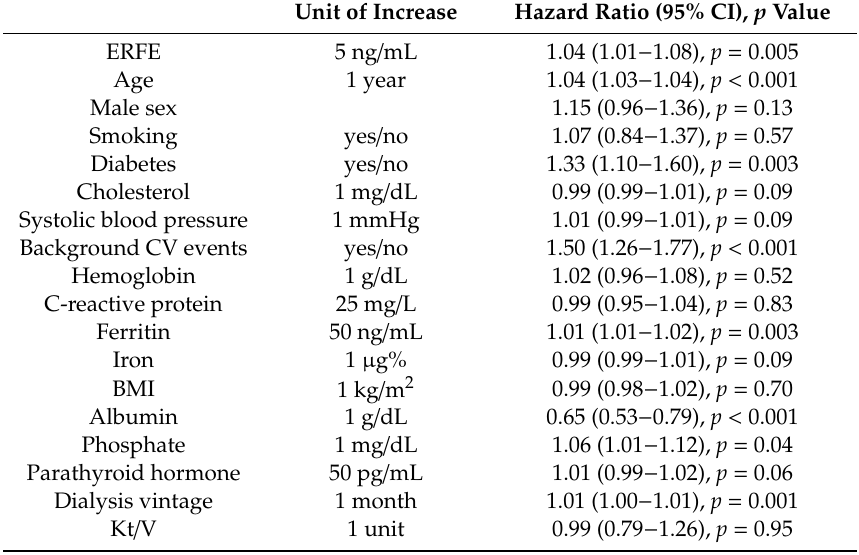
Table 2. Adjusted association between serum ERFE and mortality and non-fatal cardiovascular (CV) events in the chronic hemodialysis (HD)